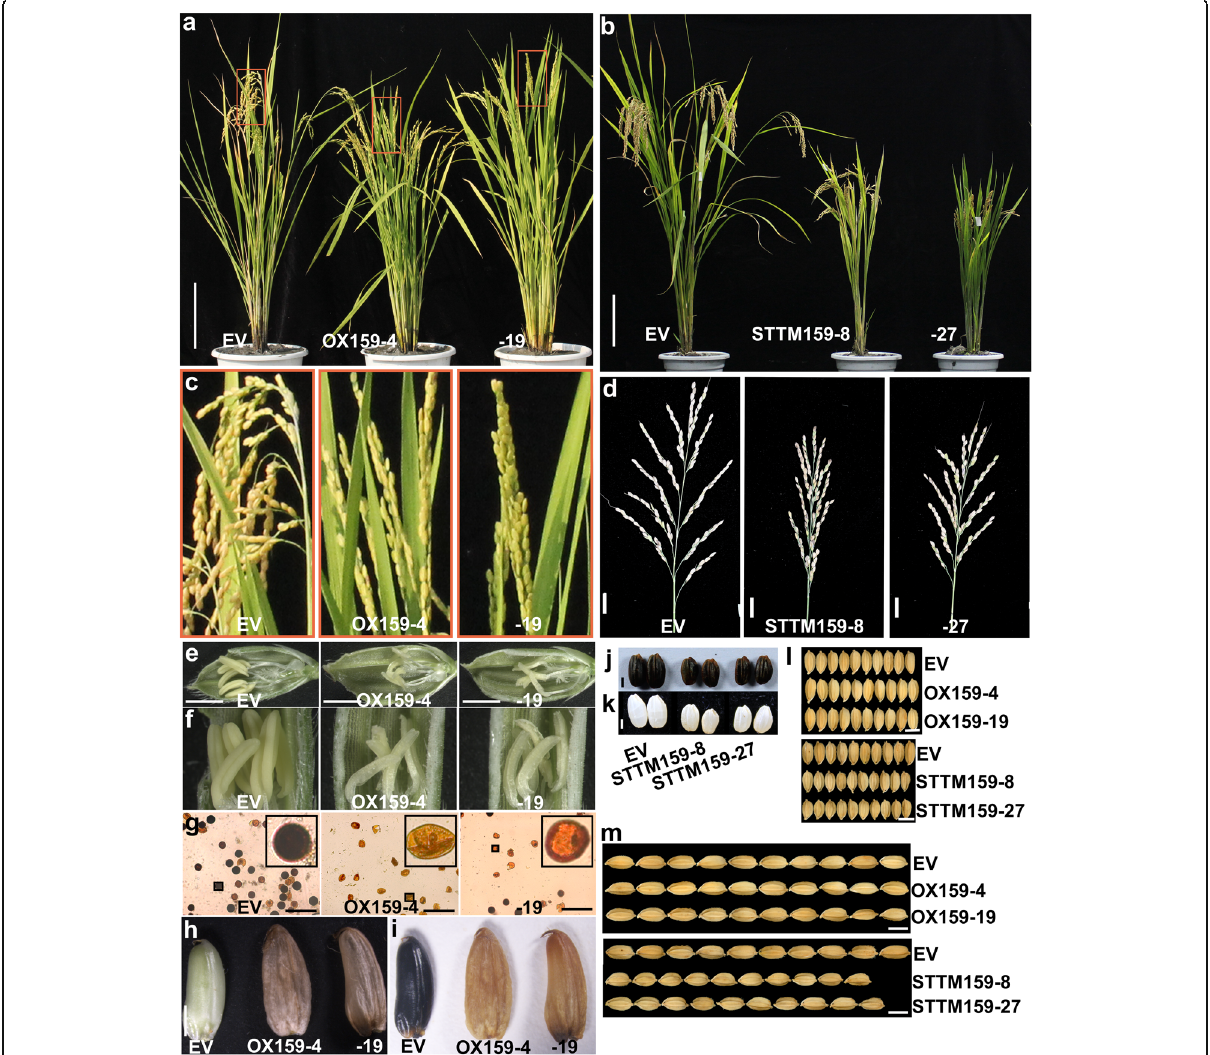
Fig. 3 Osa-miR159a influences rice traits and yield. a , b Gross morphology of the indicated lines. Scale bars, 20 cm. c , d Panicles morphology of the indicated lines. Scale bars, 2 cm in ( d ). e , f Shucked grains of the indicated lines. Scale bars, 2 mm. g Potassium iodide dye shows the starch in the pollen grain of the indicated lines. Scale bars, 100 μ m. h - k Potassium iodide dye shows the starch in seeds of the indicated lines. The pictures in ( h , k ) were captured before potassium iodide dye. The pictures in ( i , j ) were captured after potassium iodide dye. l , m Comparison of grain width ( l ) and grain length ( m ) in the indicated lines. Scale bars, 5 mm